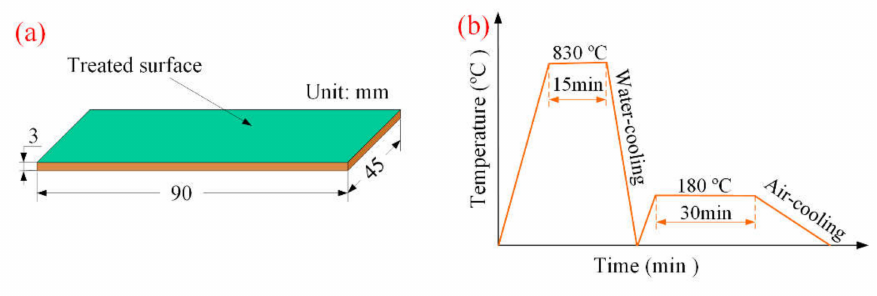
Figure 1. ( a ) The geometric parameters of samples, ( b ) The procedure of heating processing.